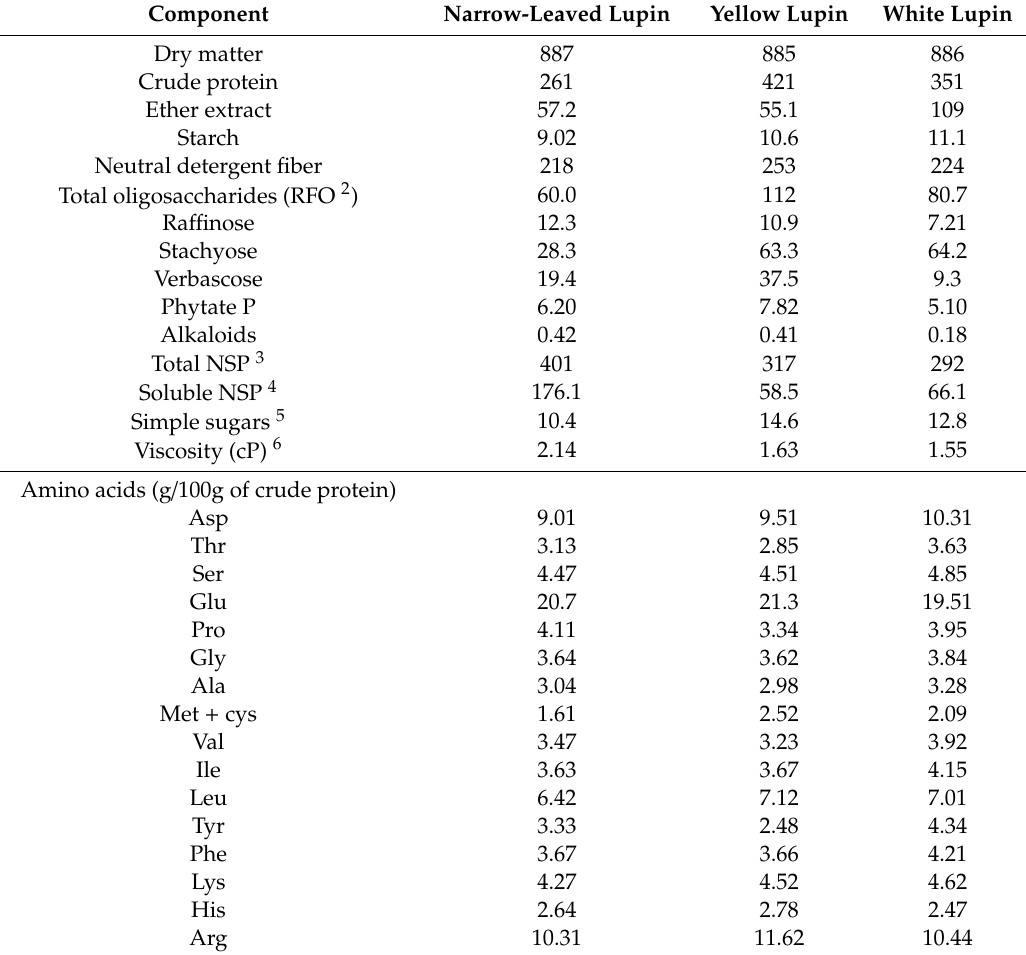
Table 1. Chemical composition of seeds of three lupin species (g / kg DM) 1